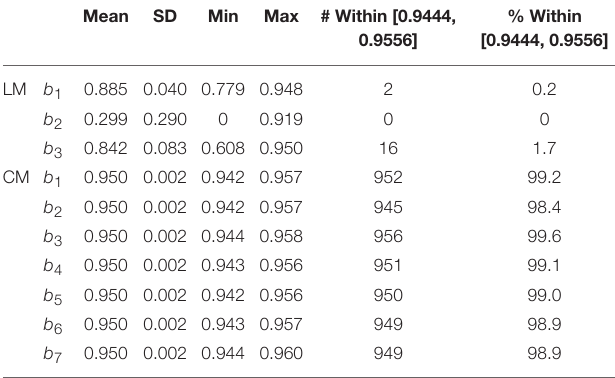
TABLE 4 | Coverage probabilities across 960 simulation